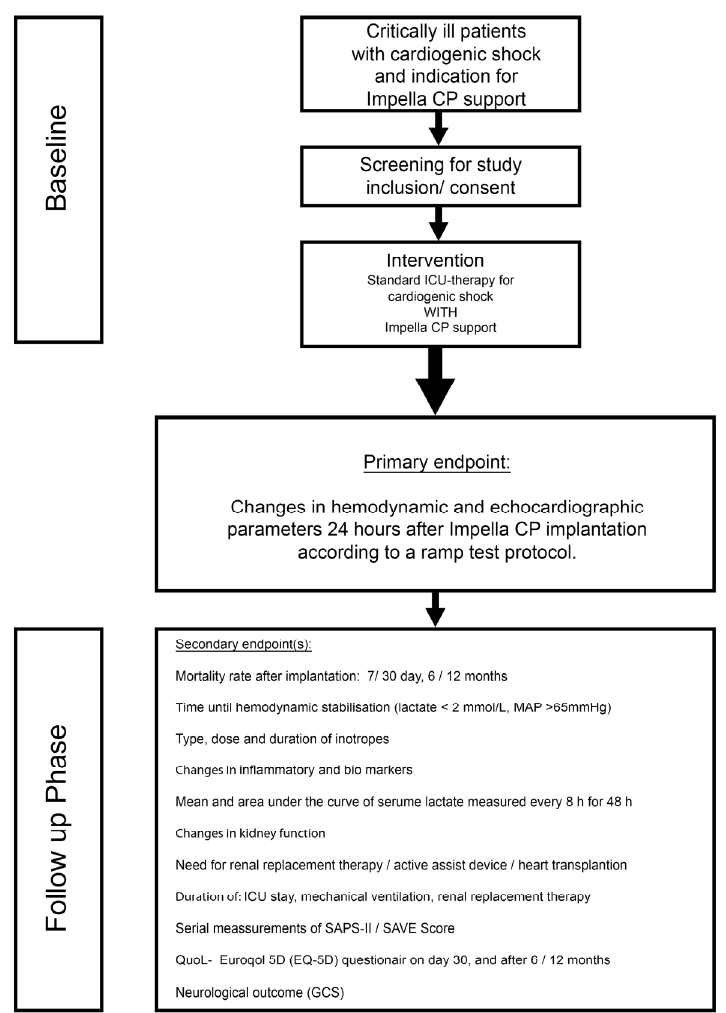
Figure 1. Flow chart of the study design. PAC = Pulmonary artery catheter; MAP = Mean arterial pressure; SAPS = Simplified acute physiology score; SAVE = Survival after VA ECMO; ICU = Intensive care unit; GCS = Glasgow outcome scale.